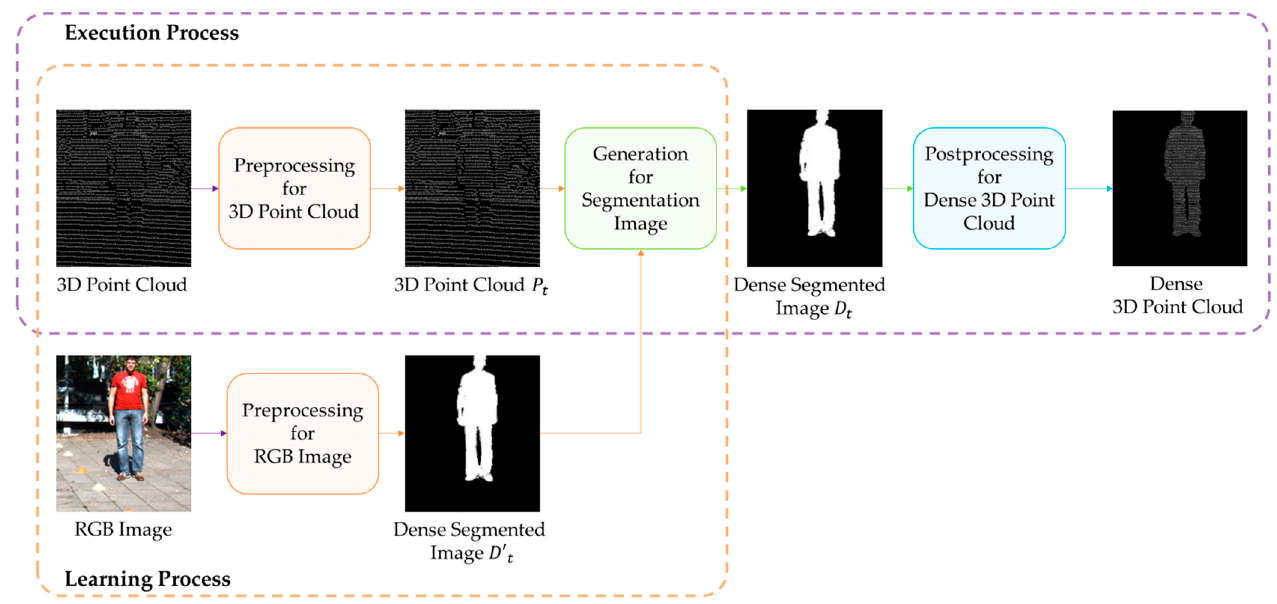
Figure 1. Process of increasing the density of the 3D point cloud for human objects in the learning and execution processes.